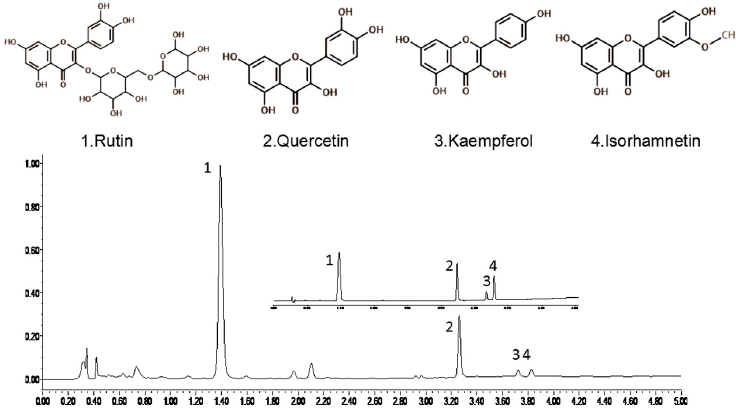
Figure 3. UHPLC chromatograms of rutin, quercetin, kaempferol, and isorhamnetin extracted from Flos sophorae samples by the IRAE method.